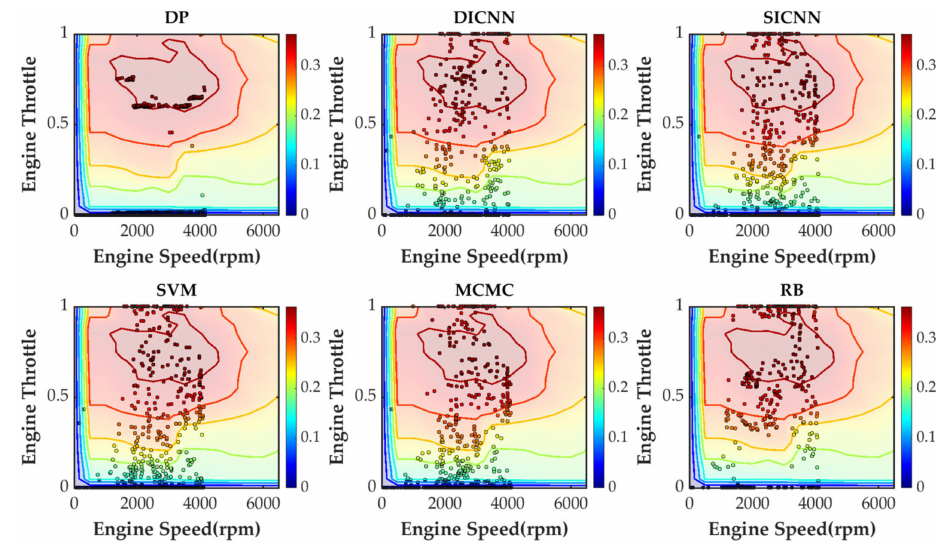
Figure 17. The distribution area of engine operating points under various strategies.